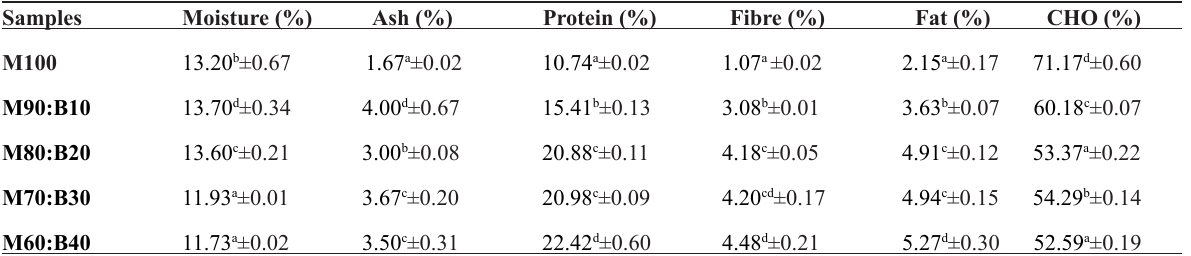
Table 1: Proximate composition of Maize-Bambara nut composite flours.